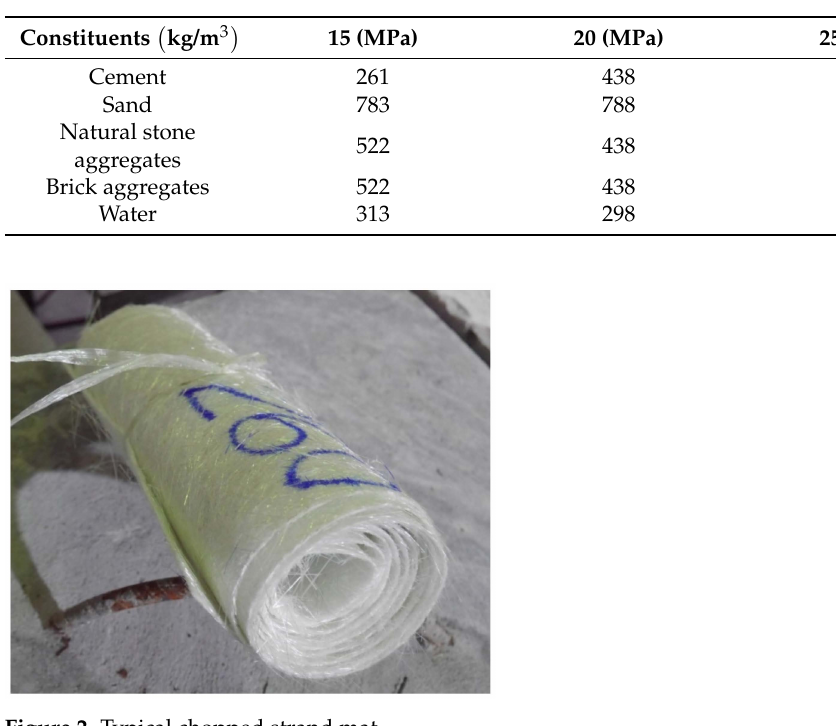
Figure 1. ( a ) Solid clay brick, and ( b ) recycled brick aggregates. Table 2. Concrete mix constituents.